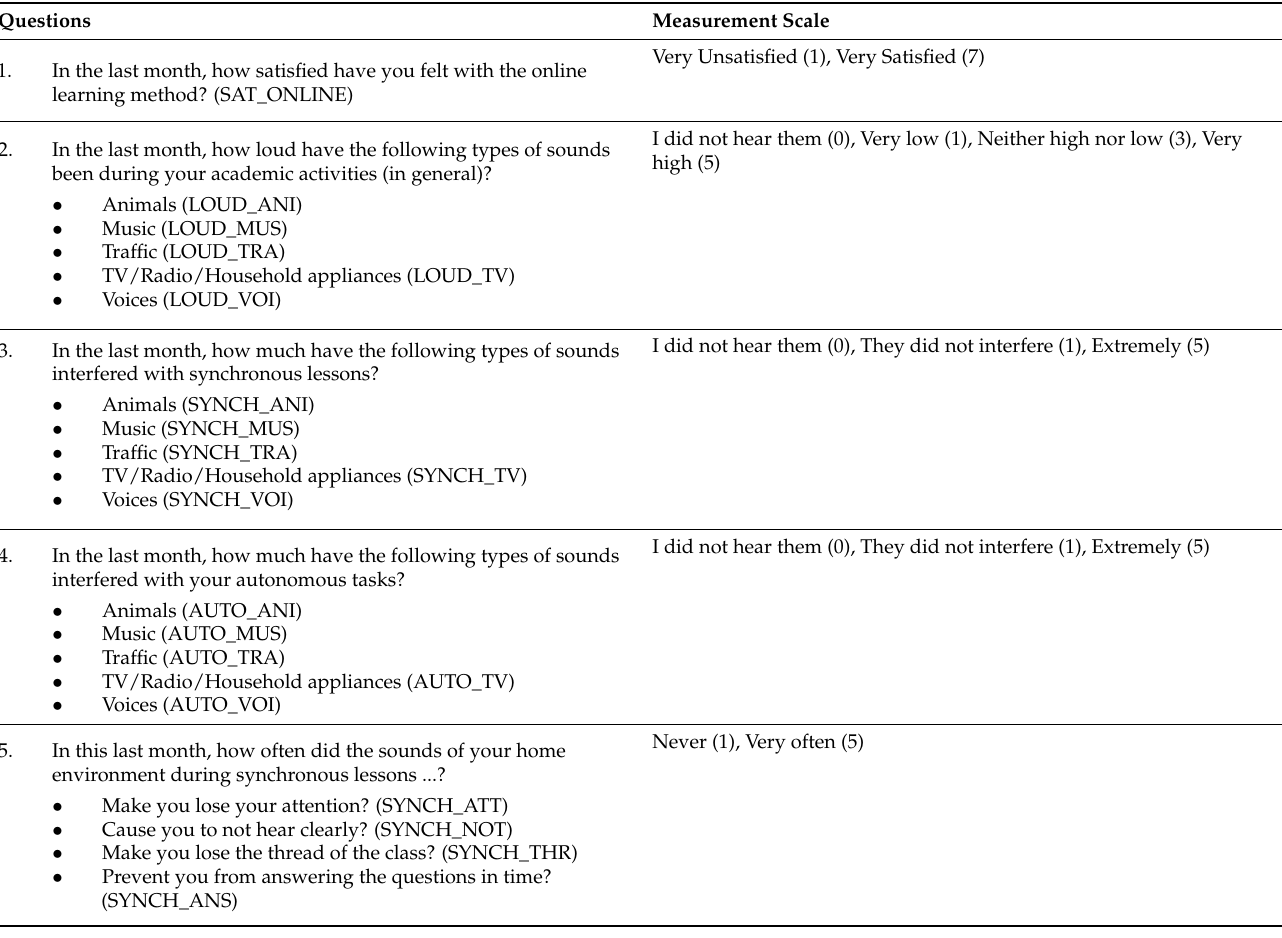
Table A1. Questions on the students’ acoustic environment at home and the students’ satisfaction with the online learning modality used for the present